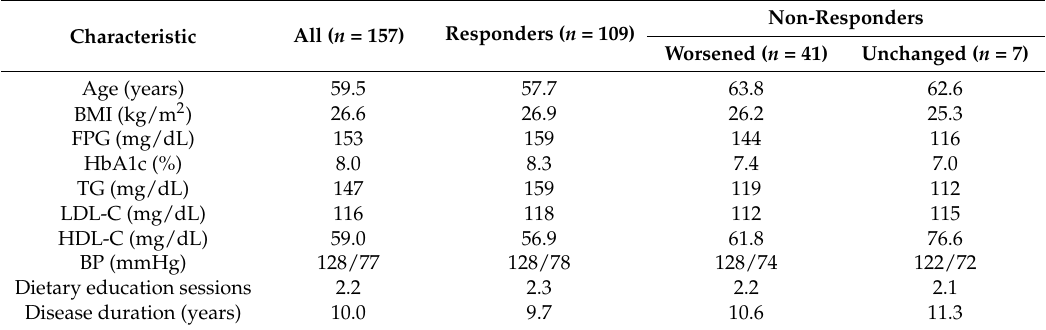
Table 4. Baseline characteristics of participants classified as responders or non-responders according to their change in HbA1c levels over the 36-month study